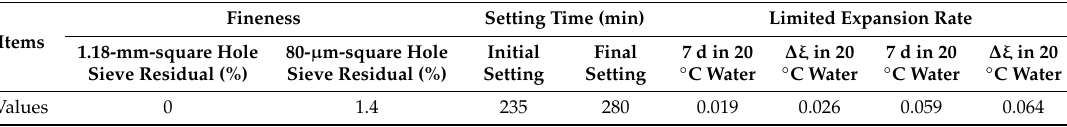
Table 4. Properties of MgO expansive agent (MEA) used in this study.